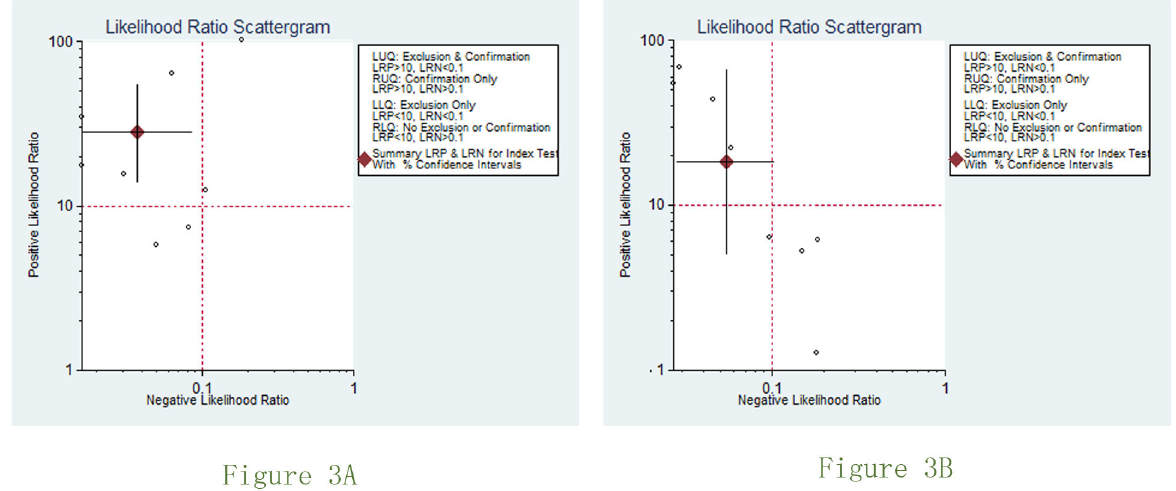
Figure 3. Scattergram of the positive likelihood ratio and negative likelihood ratio. doi: